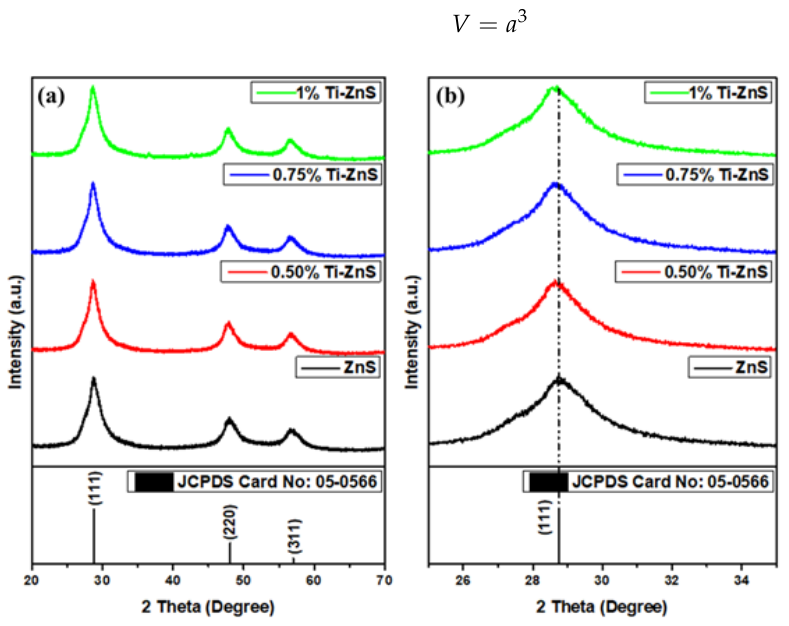
Figure 1. ( a ) XRD patterns of undoped ZnS and Ti-doped ZnS nanopowder samples at different concentrations, ( b ) peak shift at (111). Table 1. Lattice parameters, d spacing, average unit cell volume (V), average crystallite size (D), micro strain ( ε ), dislocation density ( δ ), and stacking Fault